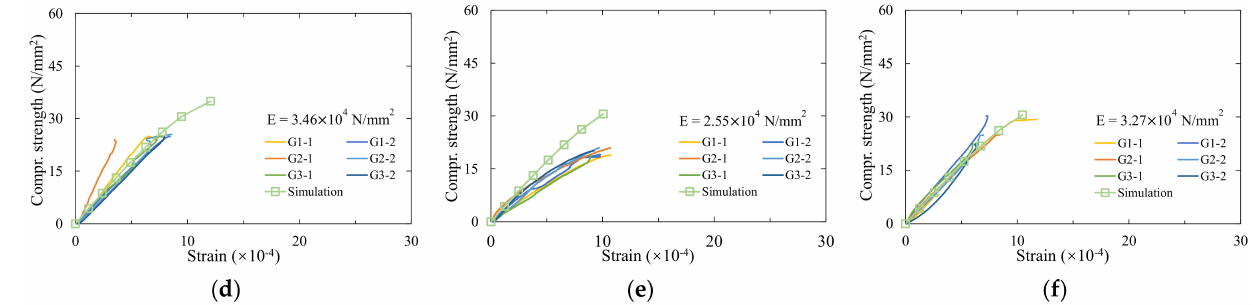
Figure 4. The stress–strain curve of SS concrete. ( a ) Conventional concrete. ( b ) SS50–20. ( c ) SS50–40. ( d ) SS60–8. ( e ) SS60–12. ( f ) SS60–16.